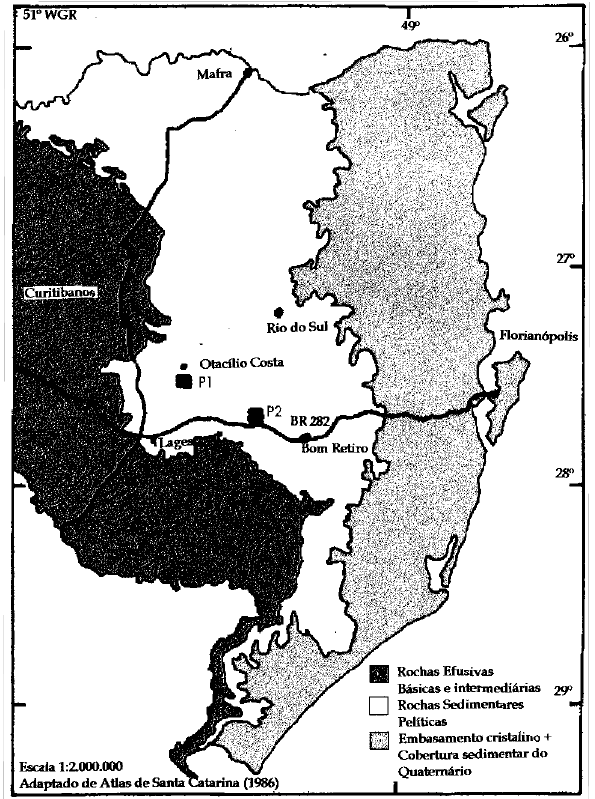
Figura 1. Mapa de localização dos sítios de amostra- gem dos perfis de Nitossolos Vermelhos (Podzóli- cos Vermelho-Escuros) estudados (P1 e